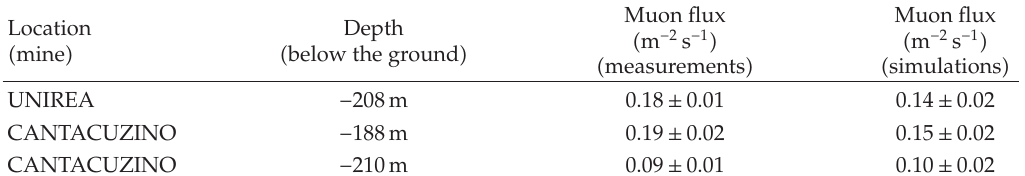
Table 1: Measurement and simulation results of underground muon fluxes at di ff erent locations of Slanic